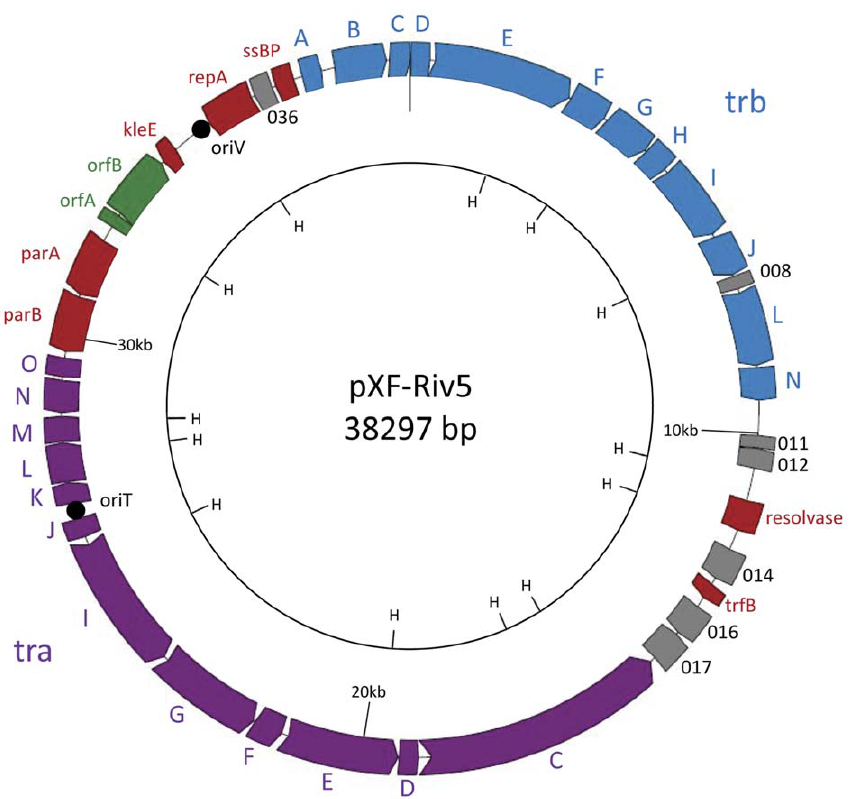
Figure 1. Genetic map of pXF-RIV5. The open reading frames are colored according to presumed function: red, plasmid replication and partition; purple, conjugative transfer (tra); blue, mating pair formation (trb); green, transposon associated; gray, hypothetical proteins of unknown function. The origin of replication ( oriV ) and the origin of transfer ( oriT ) are indicated by black circles. An inner circle marks HindIII restriction sites (H) used in